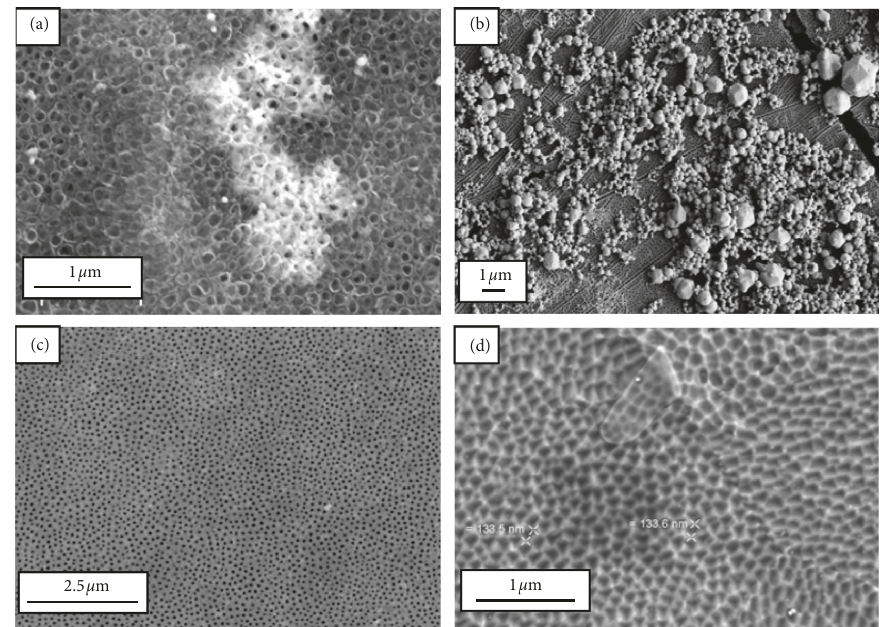
Figure 3: SEM micrographs of TiO 2 NTdisks (a) treated with AgNO 3 , followed by irradiation using Xe lamp, (b) Ag 3 PO 4 crystals grown on the surface prior to irradiation, and (c, d) two different magnification of TiO 2 NTdisks treated with Ag 3 PO 4 followed by irradiation using Xe lamp. Table 1: Elemental composition of the surface of the TiO 2 NTdisks before and after AgNO 3 treatment, after growing Ag 3 PO 4 microcrystals, and after photolysis of Ag 3 PO 4 microcrystals obtained using EDS. Element Untreated (wt.%) After AgNO 3 treatment